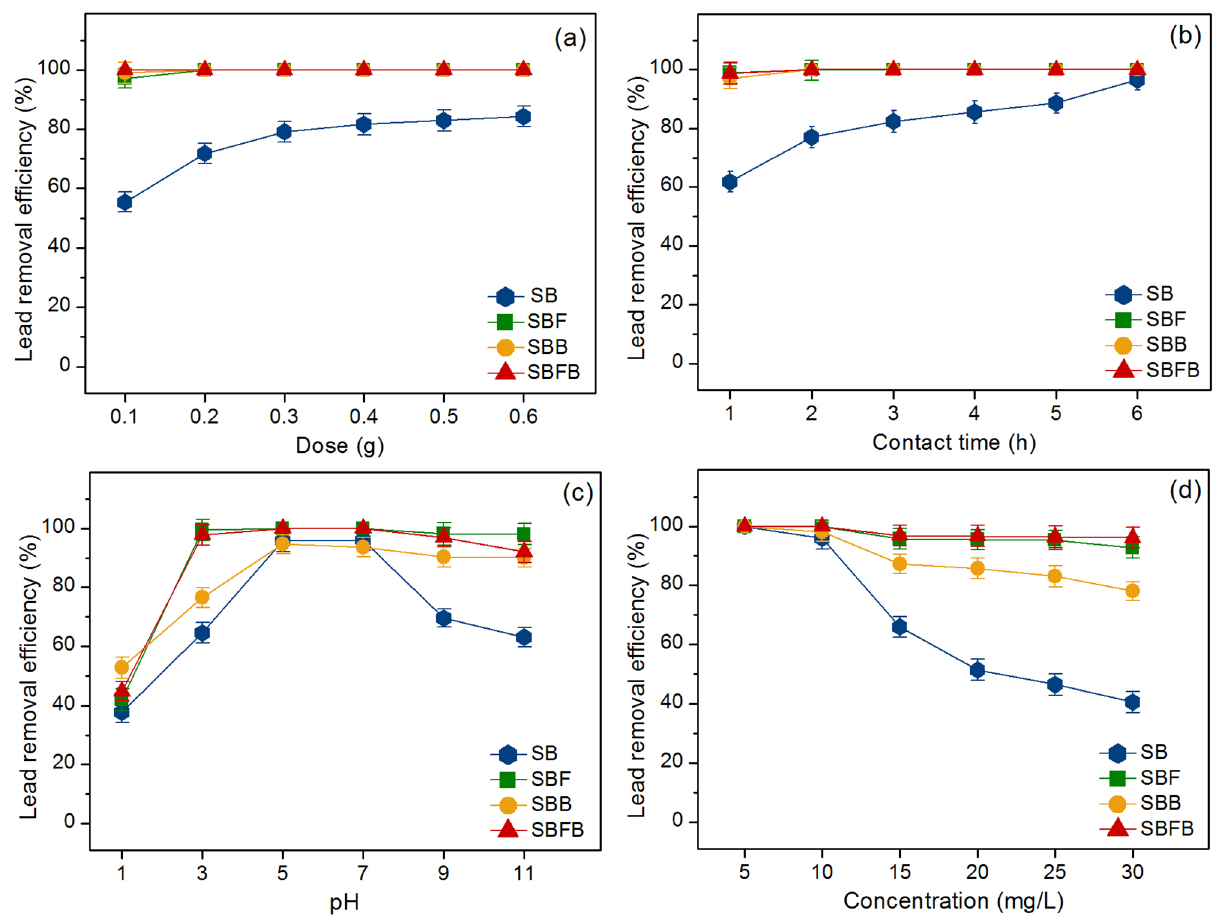
Figure 6. Batch experiments on the effects of ( a ) dose, ( b ) contact time, ( c ) pH, and ( d ) concentration of sugarcane bagasse powder (SB), sugarcane bagasse powder doped iron(III) oxide-hydroxide (SBF), sugarcane bagasse powder beads (SBB), and sugarcane bagasse powder doped iron(III) oxide-hydroxide beads